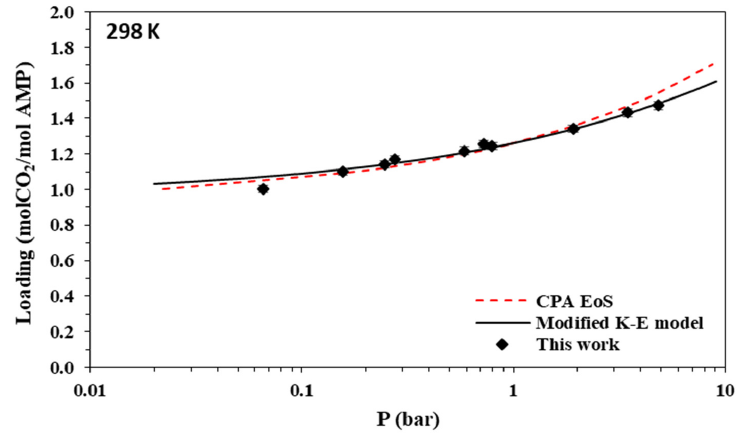
Figure 7. Solubility of CO 2 in aqueous MAPA (30.0% wt.) solutions at 298 K. Experimental data (points, from this work) and correlations (lines) with the CPA equation of state and the modified Kent–Eisenberg model.